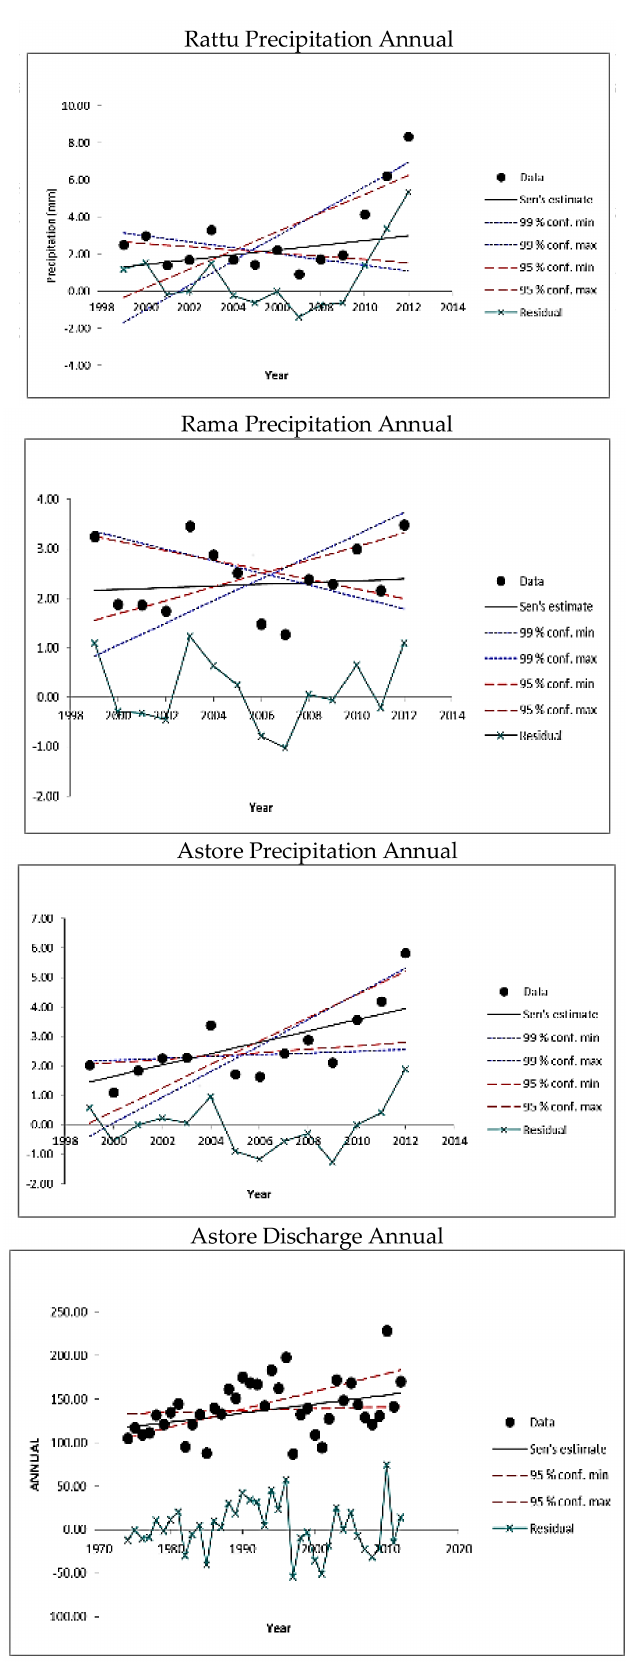
Figure A3. Astore sub-basin’s hydrometeorological trends of different